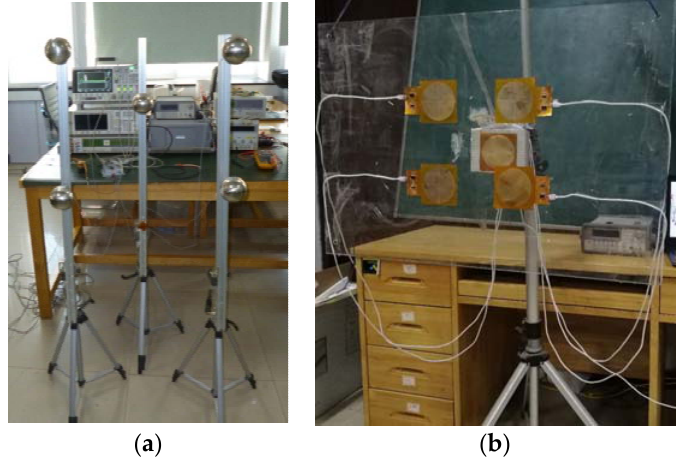
Figure 8. Photograph of our experimental equipment. ( a ) spherical electrode device and ( b ) round planar electrode device.